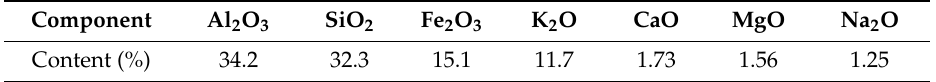
Table 1. Chemical compositions (wt.%) of soil sample.